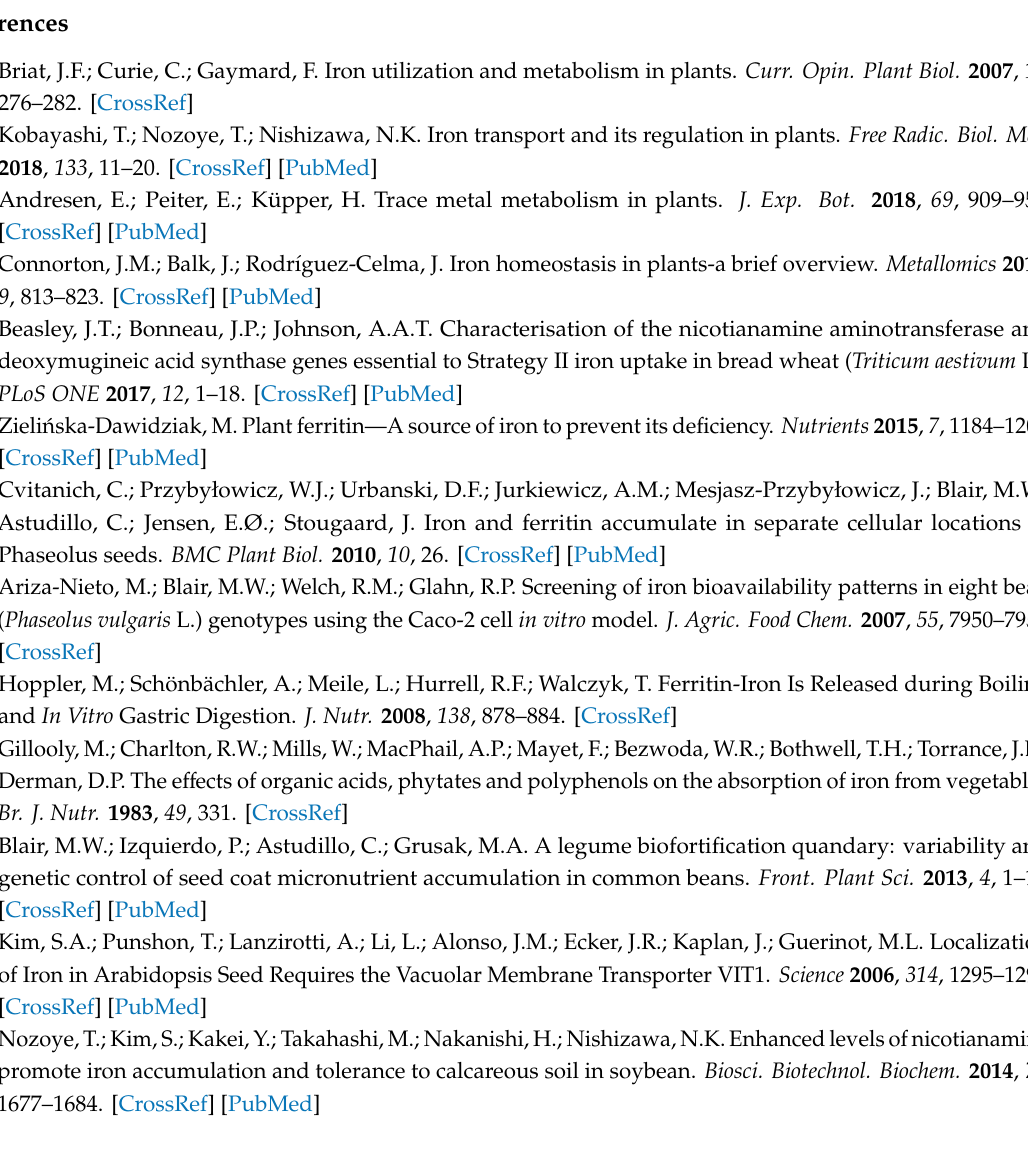
Figure S1: Ferritin formation in Caco-2 cells in response to various molar ratios of nicotianamine:myricetin (NA, red) and epicatechin:myricetin (Epi, green), Table S1: Fold increases in Caco-2 cell ferritin formation in response to di ff erent molar ratios of 2 (cid:48) deoxymugineic acid (DMA, blue), epicatechin (Epi, green), ascorbic acid (AsA, orange), and nicotianamine (NA, red) compared to ferritin formation in the presence of Fe